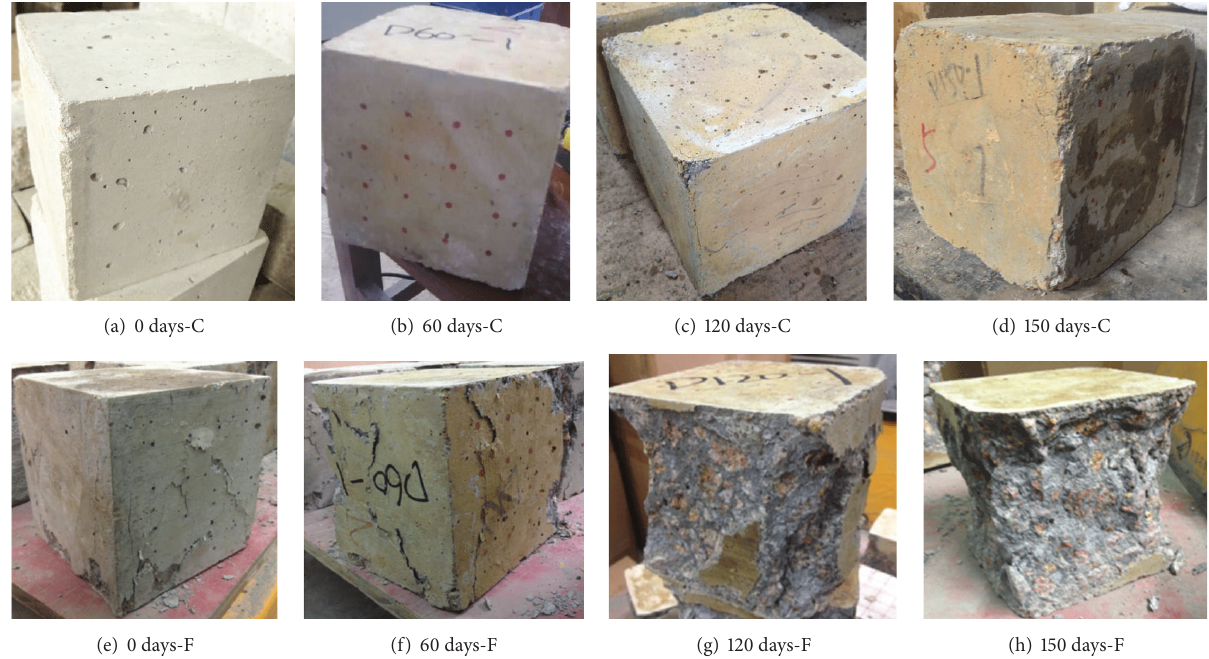
Figure 4: Corrosion morphology and compressive failure mode of concrete after various degradation periods (note that C denotes the corrosion morphology and F denotes the failure